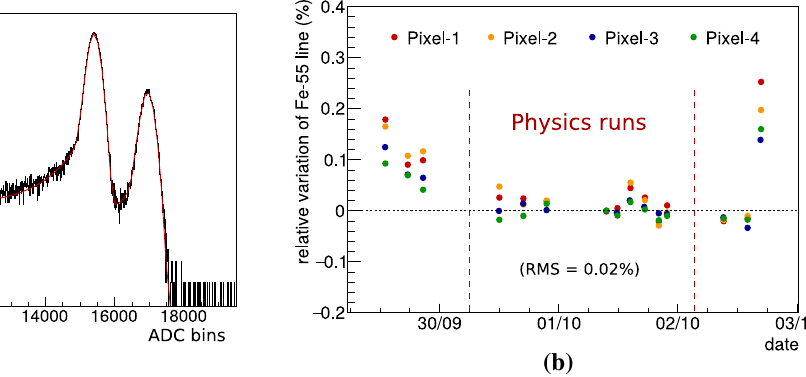
ative variation of the mean peak position of the Fe-55 calibration line at 5.90keV over the duration of the measurement campaign, relative